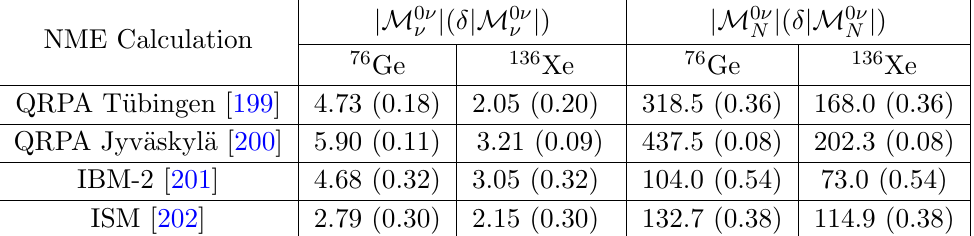
0 (cid:23) and (cid:23) j jM